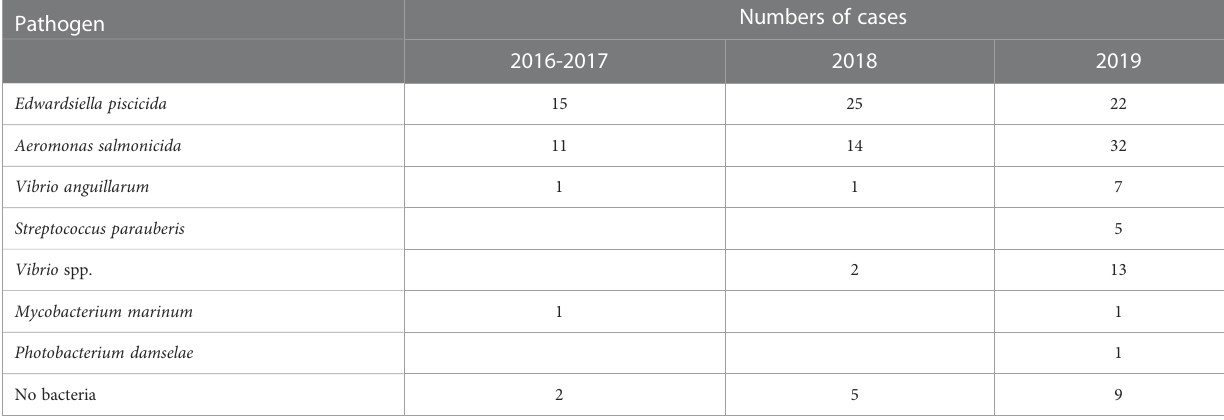
TABLE 2 Pathogens isolated from turbots from 2016 to 2019 (number of